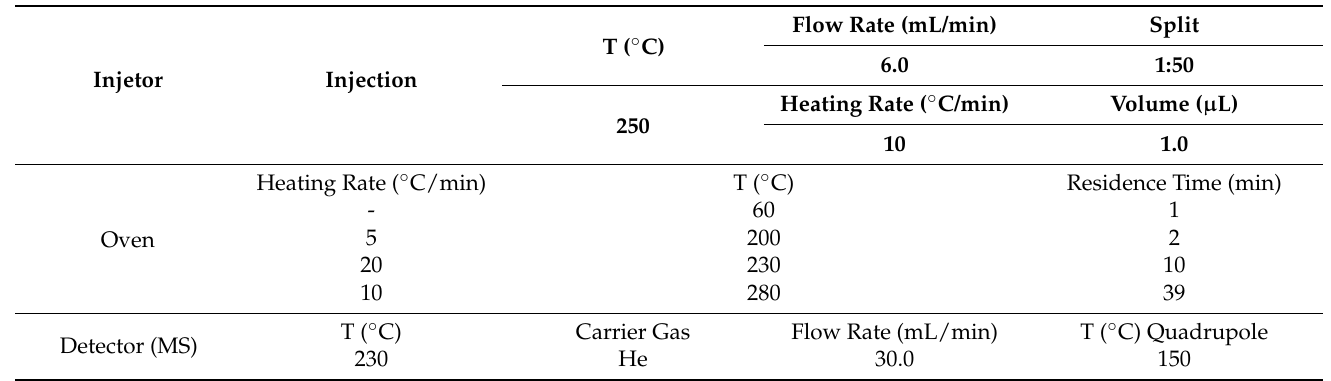
Table 1. The GC-MS operating